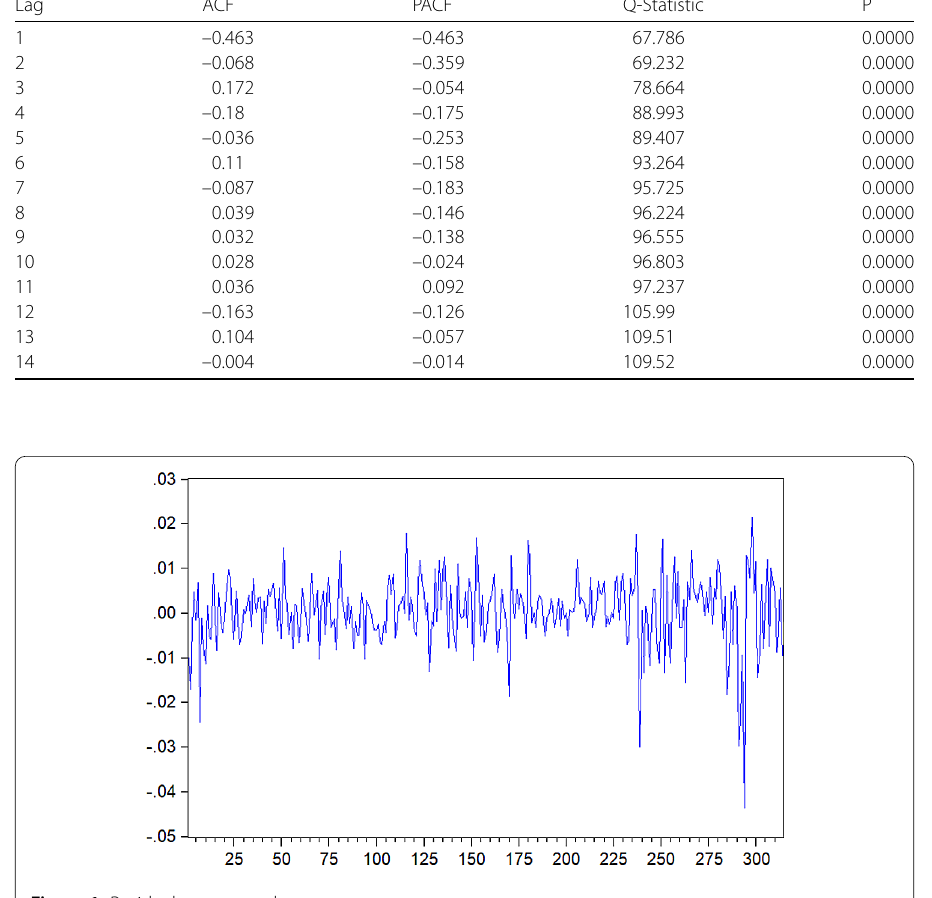
In Fig. 2 most of the scattered points deviate from the mean, showing that the